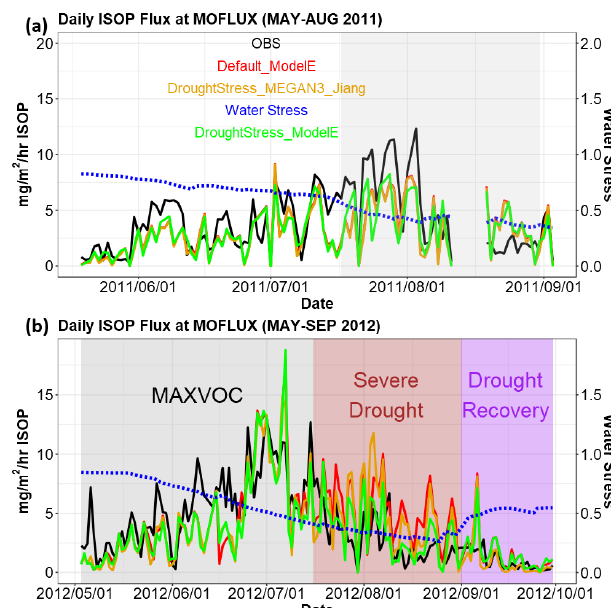
Figure 1. Daily isoprene emissions flux at MOFLUX (May–August 2011 and May–September 2012). LST time series are shown. Black shows observed isoprene emissions (abbreviated as ISOP), red shows Default_ModelE without isoprene drought stress, orange shows DroughtStress_MEGAN3_Jiang, and green shows Drought- Stress_ModelE (units: mgm − 2 h − 1 of isoprene). (a) Shaded in grey from 17 July through 31 August 2011 is the period wherein water stress falls below 0.4 for short periods. (b) Shaded in grey is the MAXVOC period, shaded in brown is the period of severe–extreme drought from 17 July through August 2012, and shaded in purple is the drought recovery